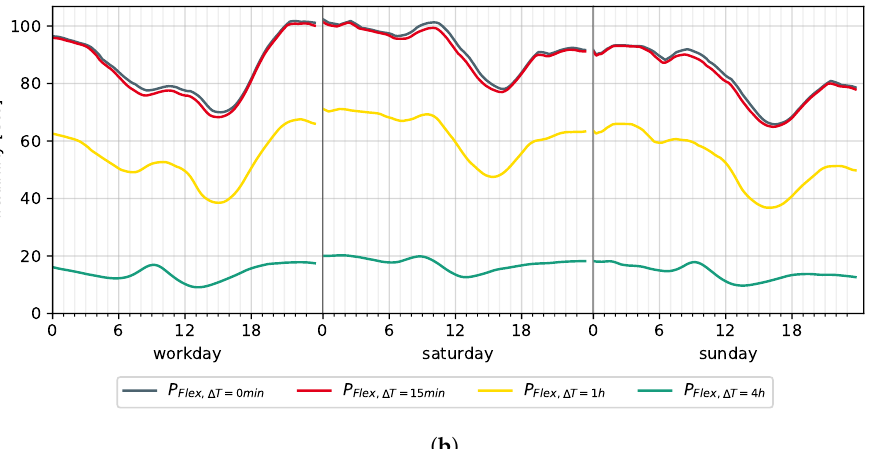
Figure 11. Impact of different product lengths (minimal provision period) on the available negative flexibility in the ( a ) sum- mer and ( b ) winter of the year